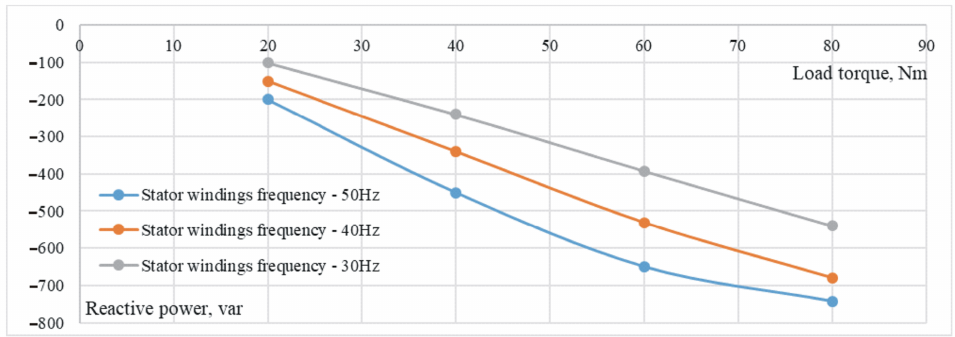
Figure 16. The reactive power at the point of single AC–DC–AC VFD connection to the PDL as a function of motor load